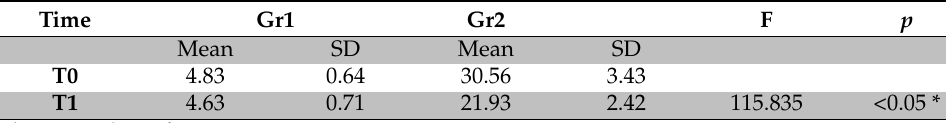
Table 13. Effect of time * group interaction on task 4